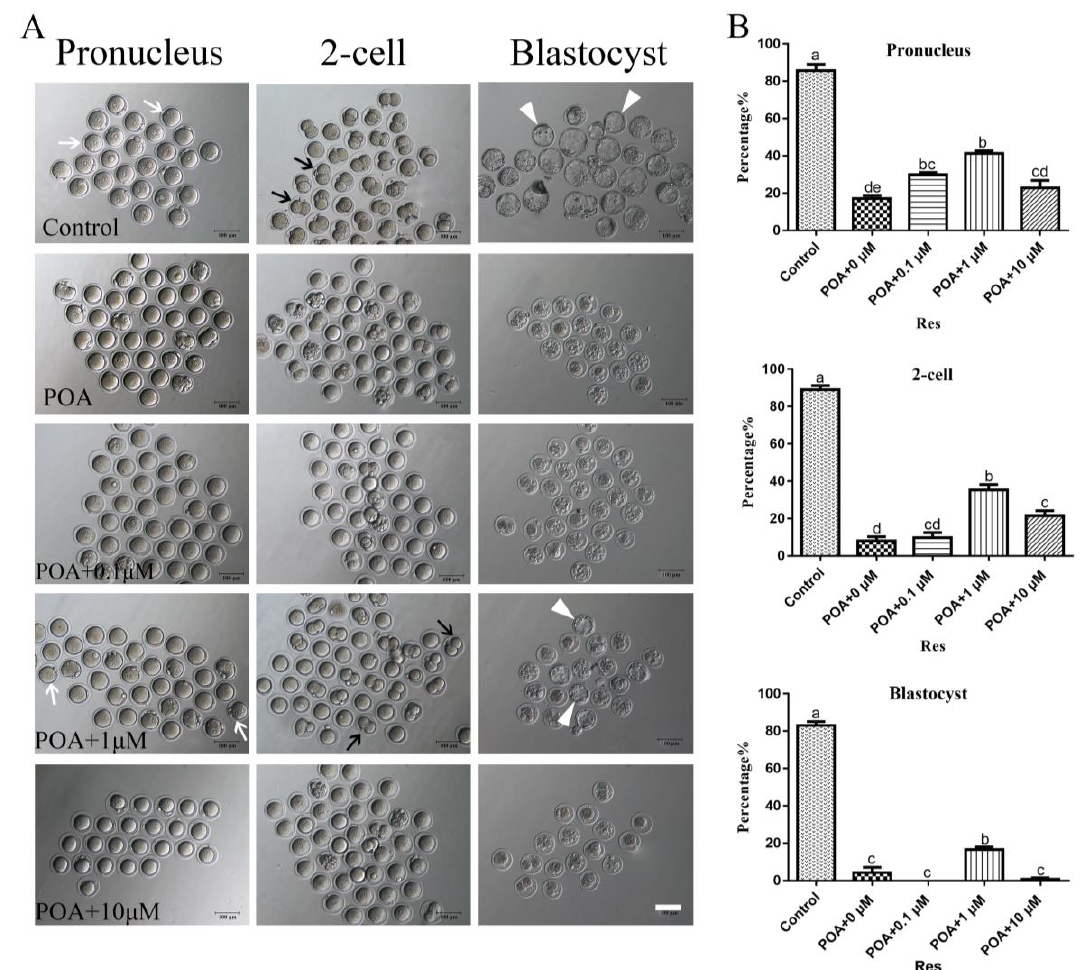
Figure 2. Resveratrol improves the rates of fertilization and early embryo development in POA oocytes. ( A ) Representative images of pronucleus, 2-cell and blastocyst in the control and POA oocytes treated with different concentrations of resveratrol (0, 0.1, 1 and 10 μM) for aging 12 h. The white arrow indicates pronucleus, the black arrow indicates 2-cell and the white triangle indicates blastocyst. Scale bar = 100 μm. ( B ) The rates of pronucleus, 2-cell and blastocyst in the control and POA oocytes treated with different concentrations of resveratrol (0, 0.1, 1 and 10 μM) for aging 12 h. Data are presented as mean ± SEM from at least three independent experiments. a – e means not sharing a common superscript is different ( P < 0.05).